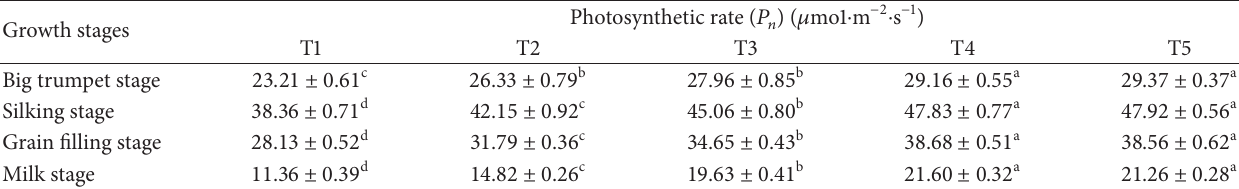
Table 3: Effects of Si application on net photosynthetic rate ( 𝑃 𝑛 ) in leaves of maize. Growth stages